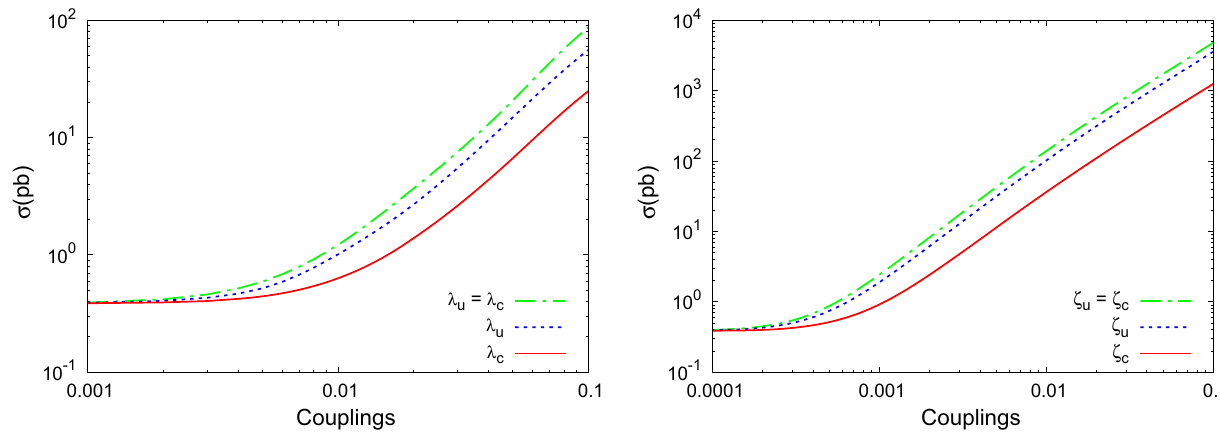
Fig. 2 The total cross section of pp → Wb γ process as a function of anomalous FCNC tq γ ( λ u and λ c ) and tqg ( ζ u and ζ c )